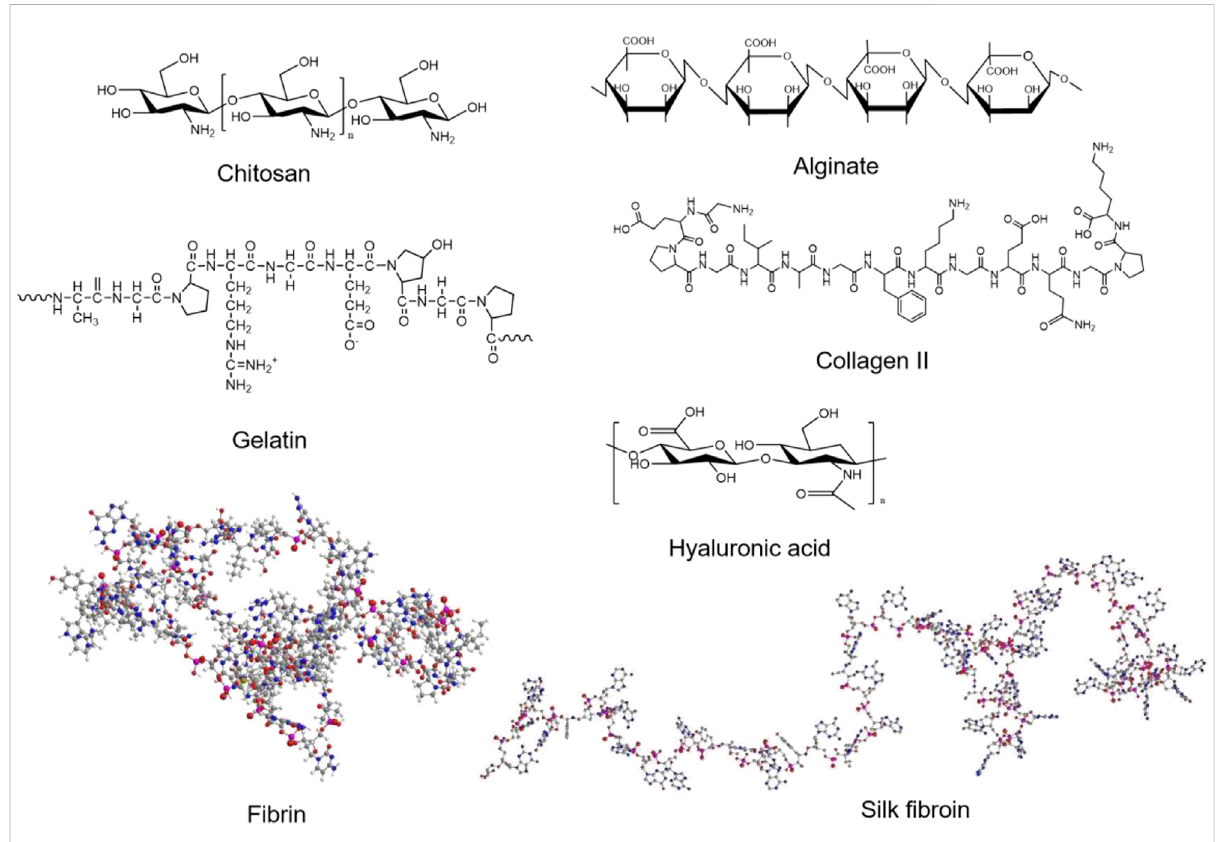
FIGURE 6 The structure of natural materials for preparing